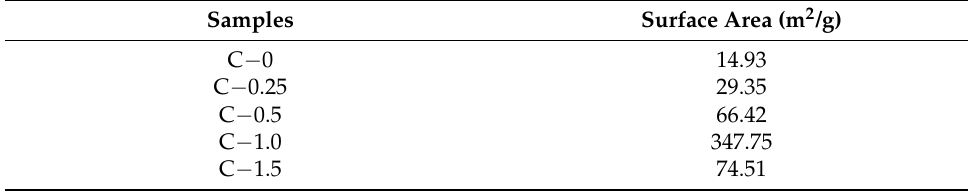
Table 1. The BET surface area of carbon fiber membrane based on potassium citrate/PAN.